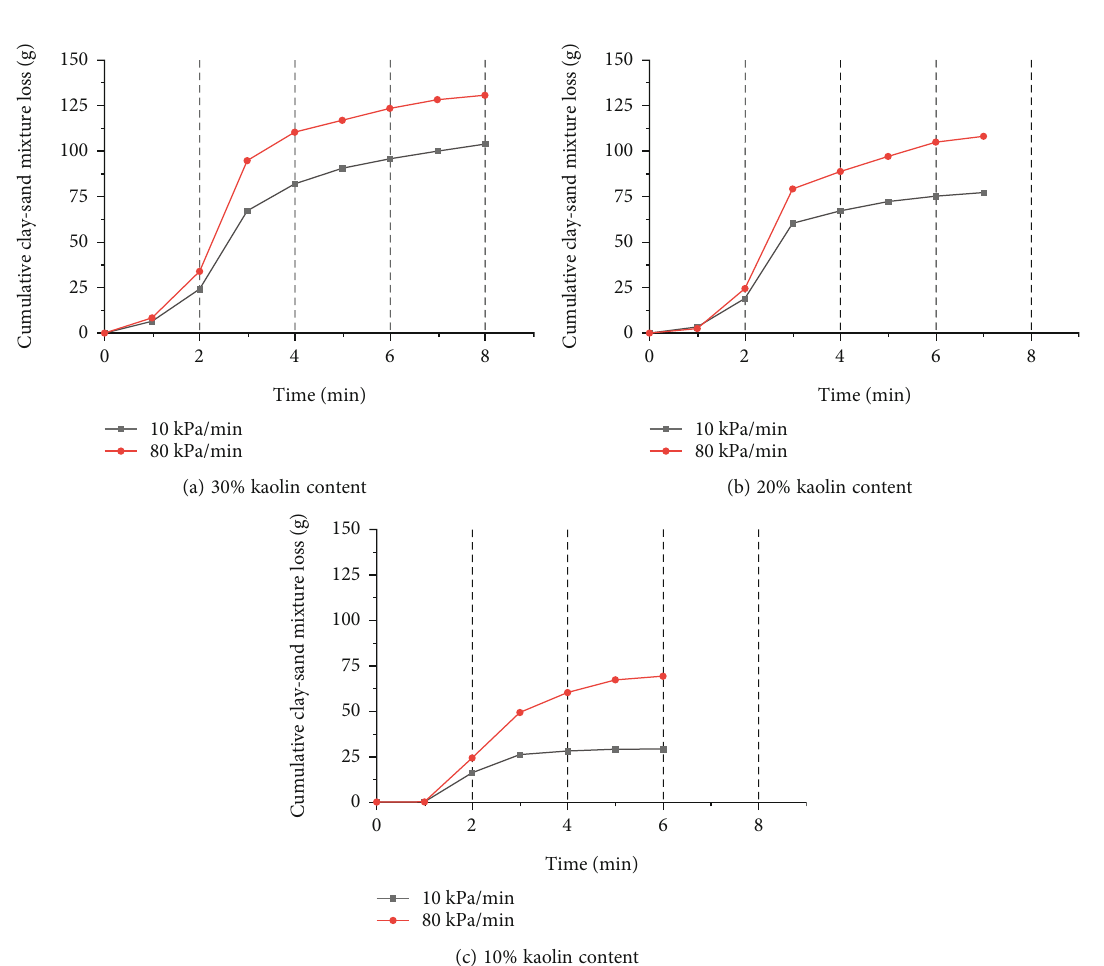
Figure 7: Variation curves of cumulative clay-sand mixture loss for di ff erent seepage pressure loading